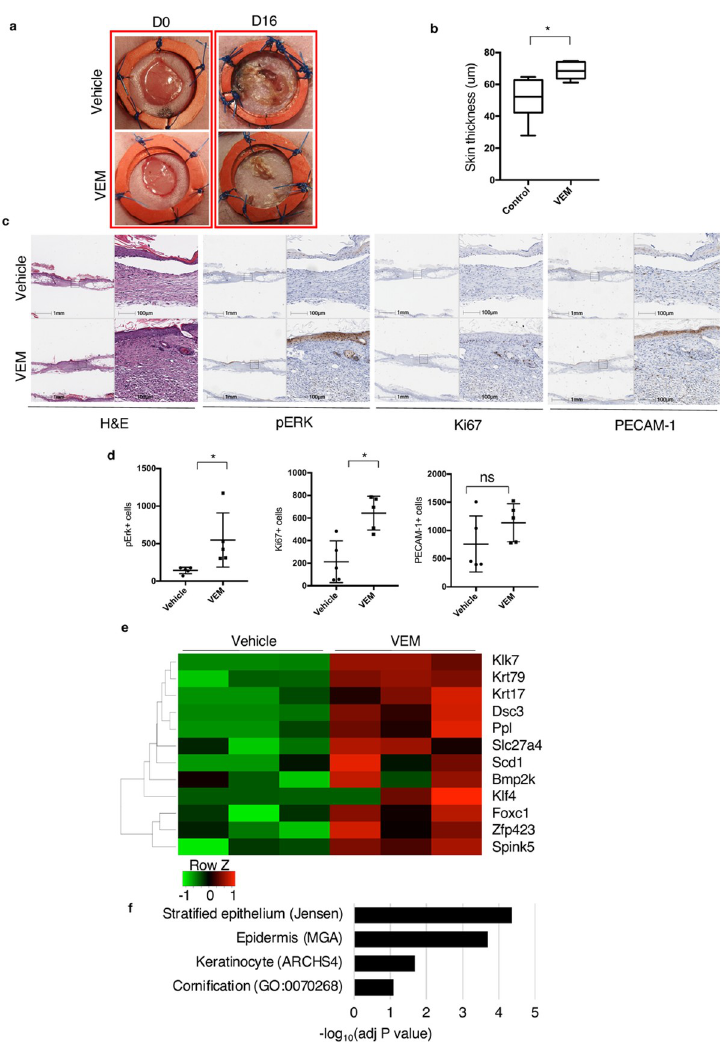
Fig 2. Topical vemurafenib promotes wound closure in diabetic wounds by Day 16. (a) Representative images of vehicle- and vemurafenib-treated wounds on day 0 and day 16. (b) Epidermal+dermal thickness quantification of vehicle- and vemurafenib-treated wounds by Day 16 ( � P = 0.02). (c) Representative H&E, pERK and Ki67 staining IHC images in the presence and absence of vemurafenib by day 16. (d) Scatter plots representing the quantification of pErk+ (P = 0.04), Ki67 ( � P = 0.015); for control wounds versus treated wounds on day 16. (e) Heatmap of representative genes that are differentially expressed either the vemurafenib-treated or control wounds on Day 16. (f) Pathway/gene ontology enrichment analyses of the full list of differentially expressed genes (at least 1.5-fold difference) using ENRICHR. Enriched gene sets (adjusted P � 0.1, Jensen: Jensen tissues database, MGA: mouse gene atlas, ARCHS4: tissue RNAseq dataset, GO: gene ontology database) are listed. NS, not significant; H&E, hematoxylin and eosin; IHC, immunohistochemistry. Error bars in b and d, mean ± s.d. Bar graphs represent one experiment with 5 replicates per